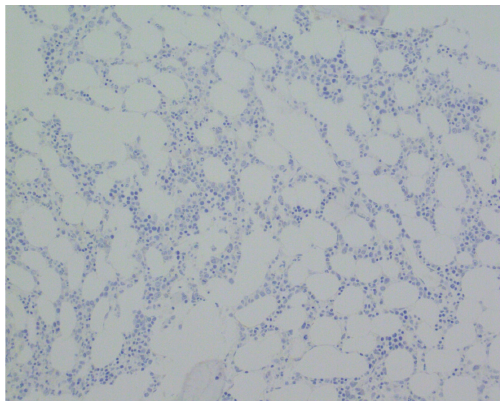
Figure 2: Marked megakaryocyte nuclear fragmentation, bone marrow aspirate, ICSH Romanovsky stain × 1,000.